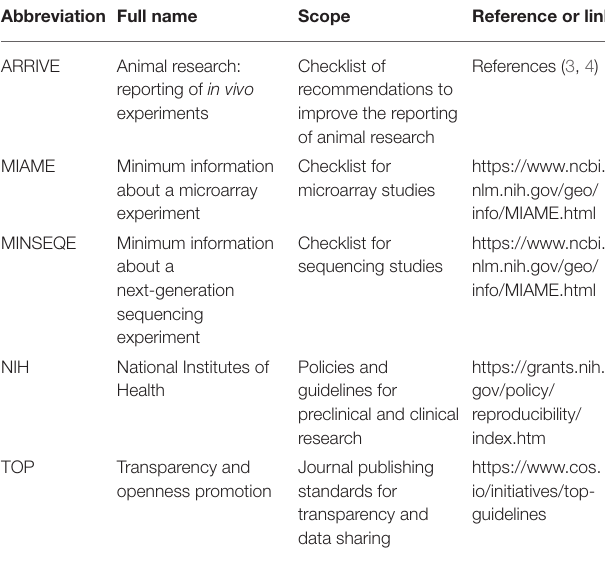
TABLE 1 | Selected major guidelines for transparent